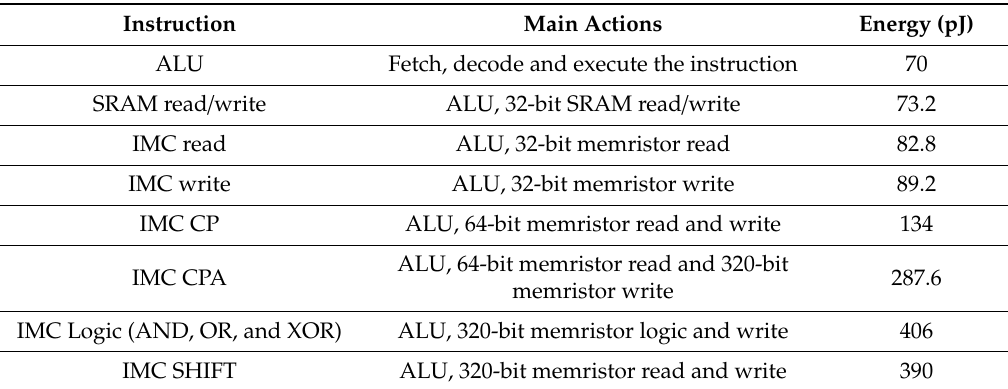
Table 6. The average energy consumption for each instruction in the 28-nm